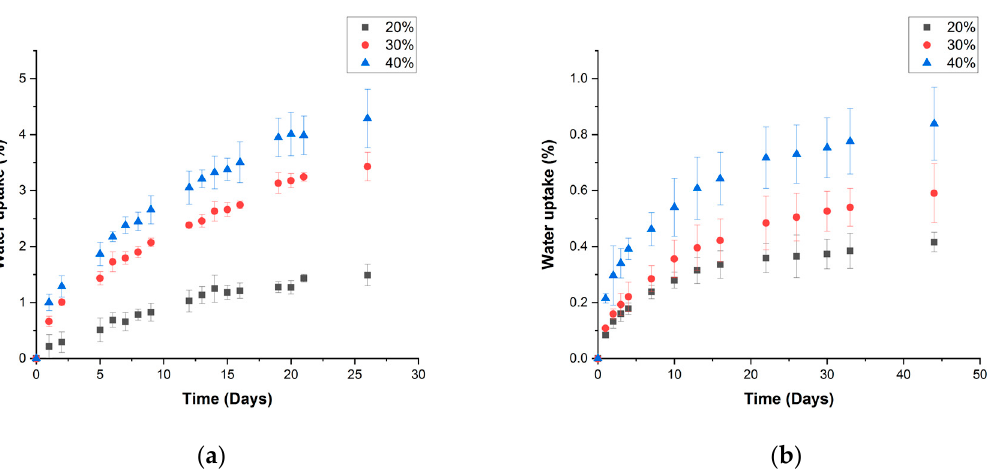
Figure 5. Water-absorption profiles PP composites reinforced with hemp strands under ( a ) immersion conditions and ( b ) 50% RH.